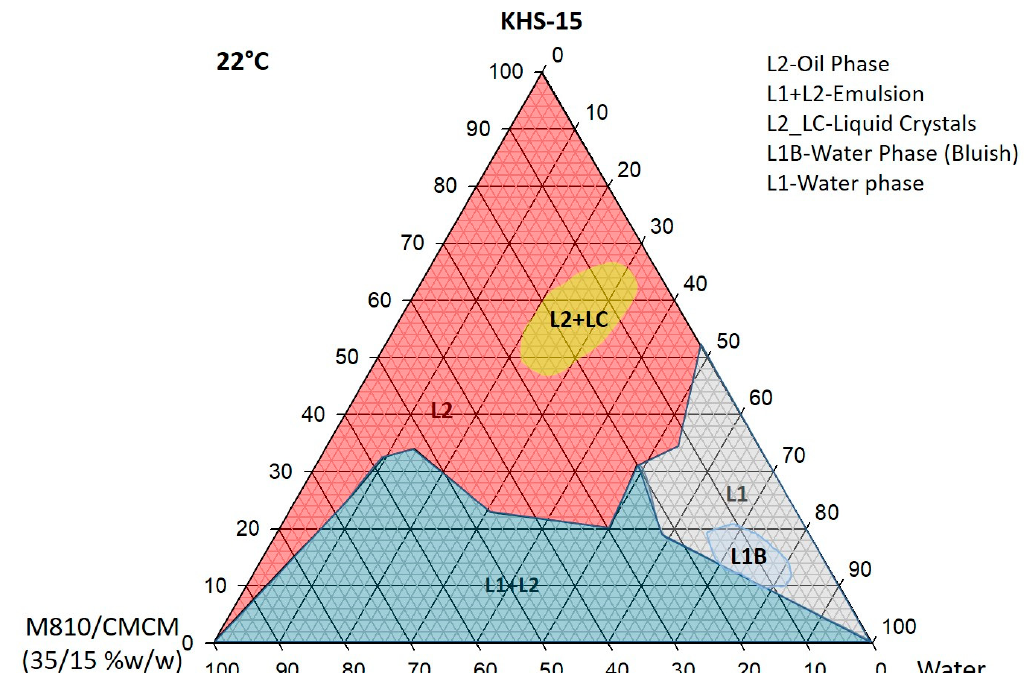
Figure 1. Ternary phase diagram of M810:CMCM (7:3)/HCO-30/water systems at 22 °C, in which L1 denotes a clear aqueous phase, L2 a transparent oily phase, L1 + L2 a milky emulsion, L2 + LC an oily phase with liquid crystals, and L1B a water continuous bluish phase.